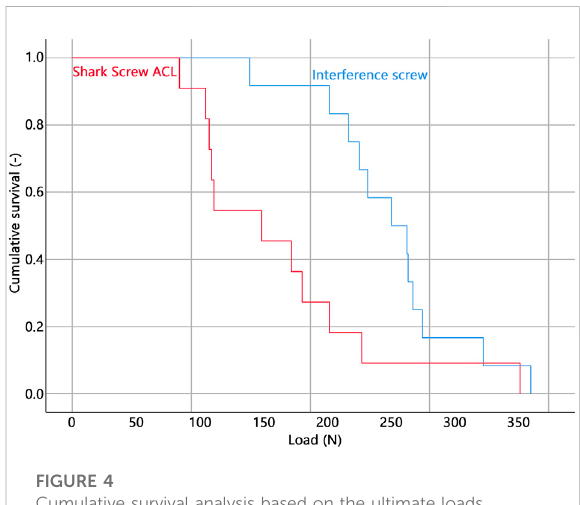
FIGURE 4 Cumulative survival analysis based on the ultimate